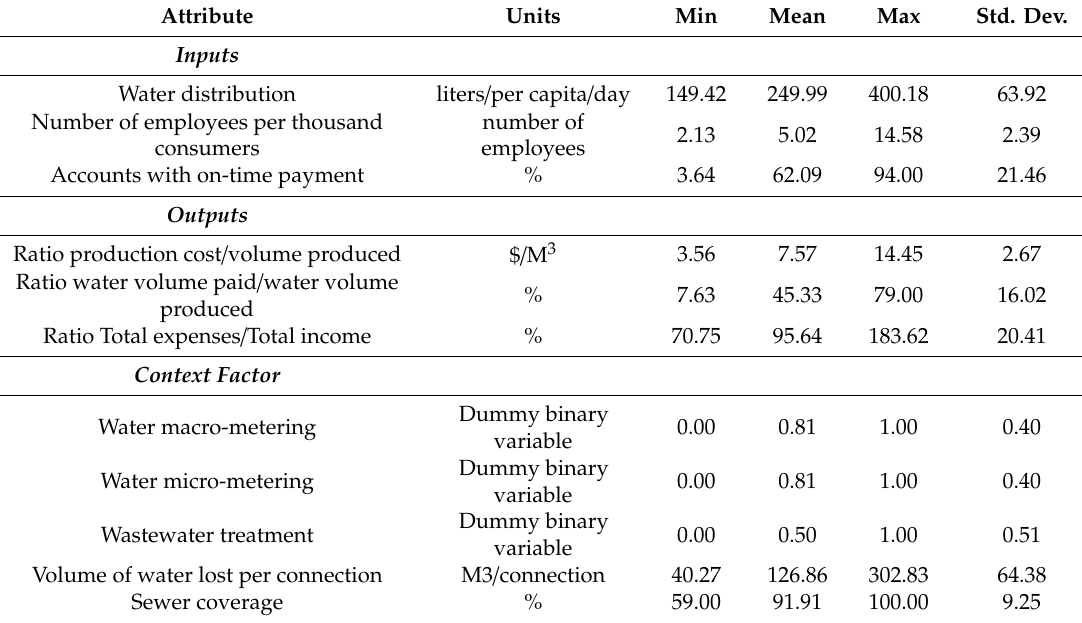
Table 8. Summary of